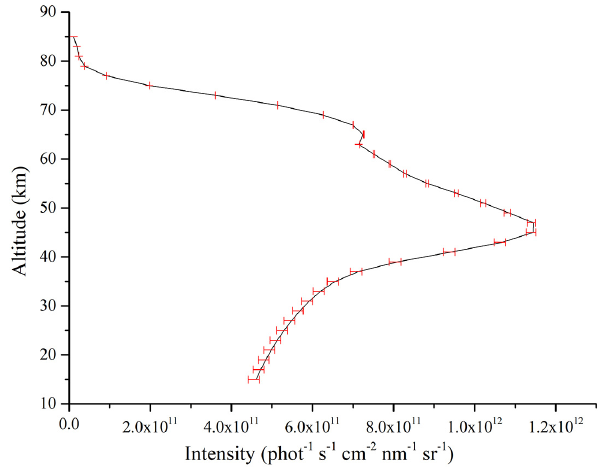
Figure 20. Relative errors in OH fluorescence emission radiance caused by the Doppler effect in the tomographic retrieval algorithm. The red error bars indicate the relative errors caused by the Doppler effect. Table 7. Relative errors in the OH fluorescence emission radiance caused by the Doppler effect at some tangent heights.